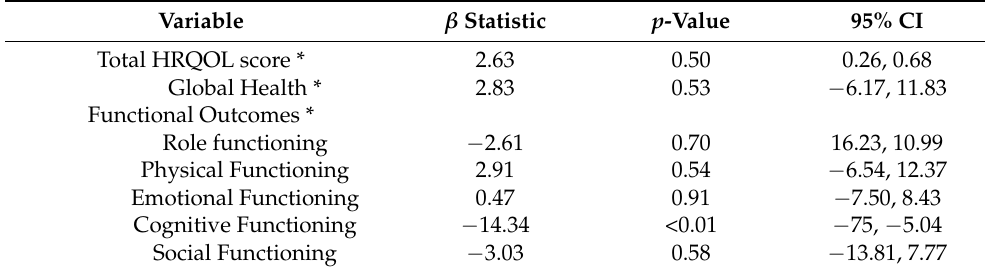
Table 4. HPV-positive and HPV-negative in a linear mixed model of mean Health Related Quality of Life (QLQ C30) across end of treatment, 1 months and 3 months post